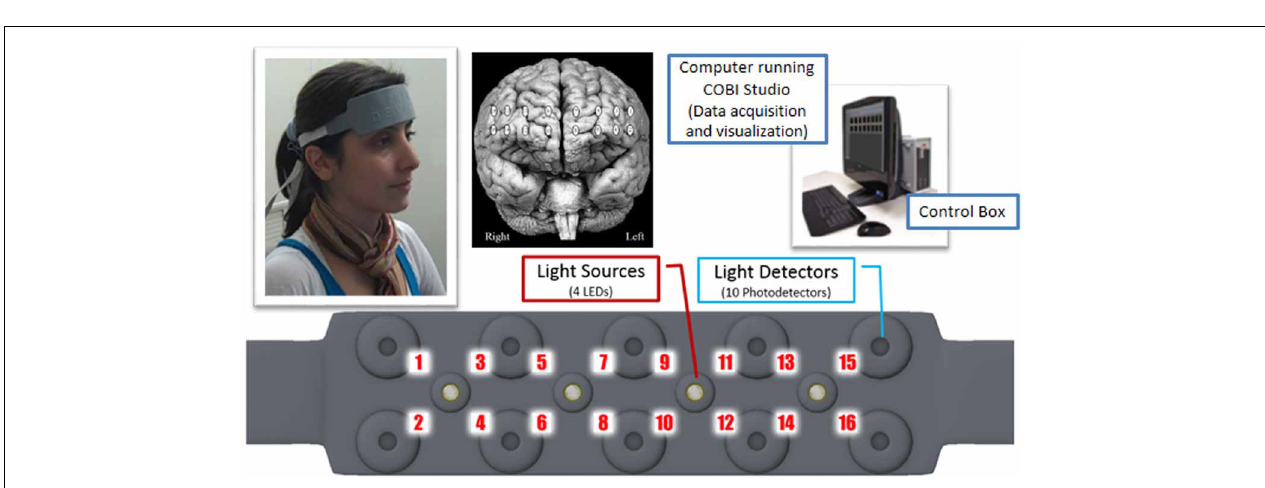
fNIRS measures: average total hemoglobin concentration changes (right) of all subjects throughout days. Error bars are standard error of the mean (SEM).